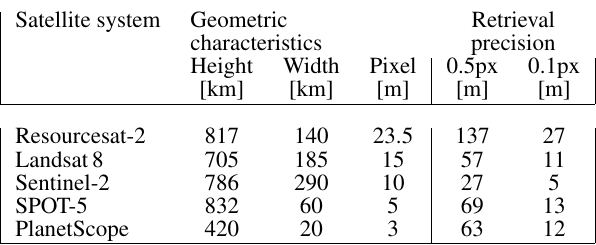
Table 2. Expected highest precision achievable for height retrieval through different sun-synchronous